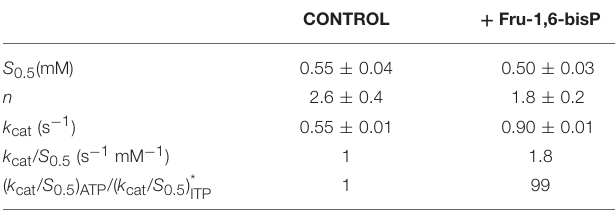
TABLE 3 | Kinetic parameters for